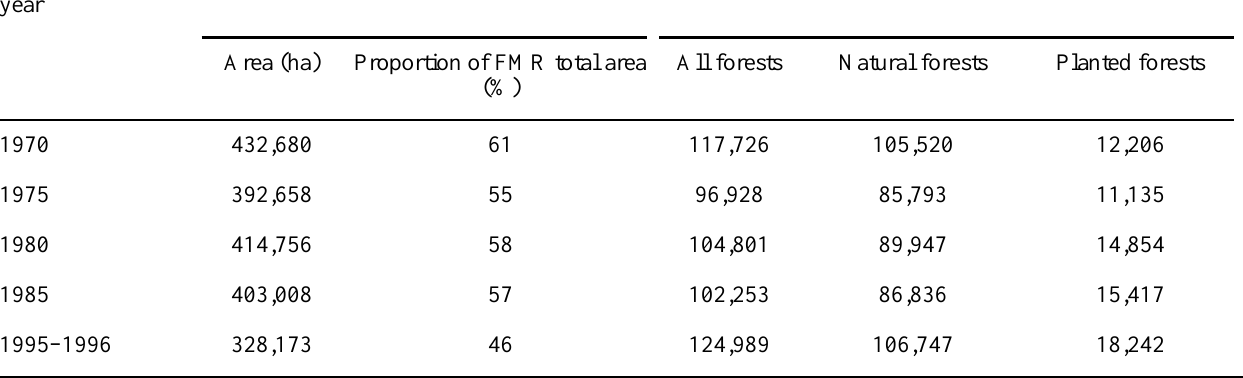
Table 1. Extent of rural private property and private forests in the Florianópolis metropolitan region (FMR), 1970 to